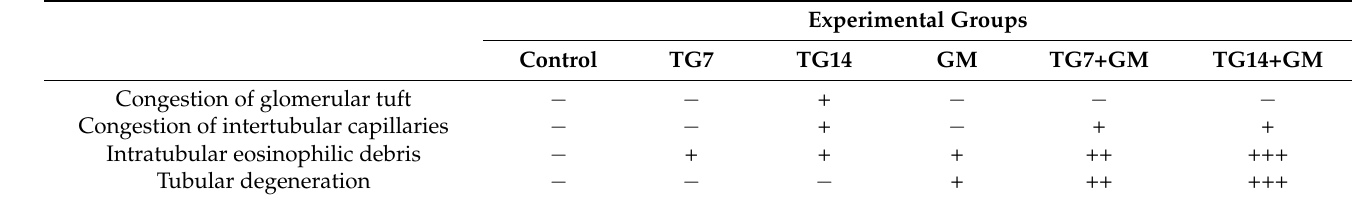
Table 1. A summary of the renal histopathological changes among the different